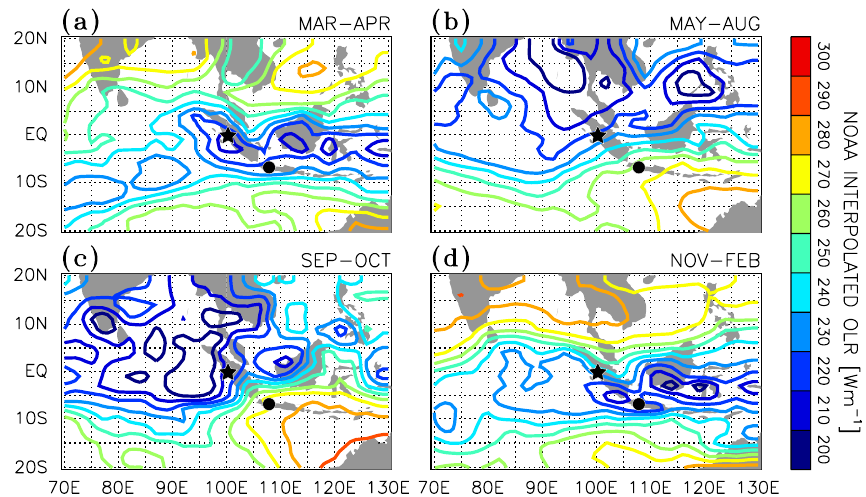
Fig. 5. Averaged OLR map over West-Indonesia for (a) March–April, (b) May–August, (c) September–October, and (d) November–February. The black star and circle indicate the locations of Kototabang and Tanjungsari,